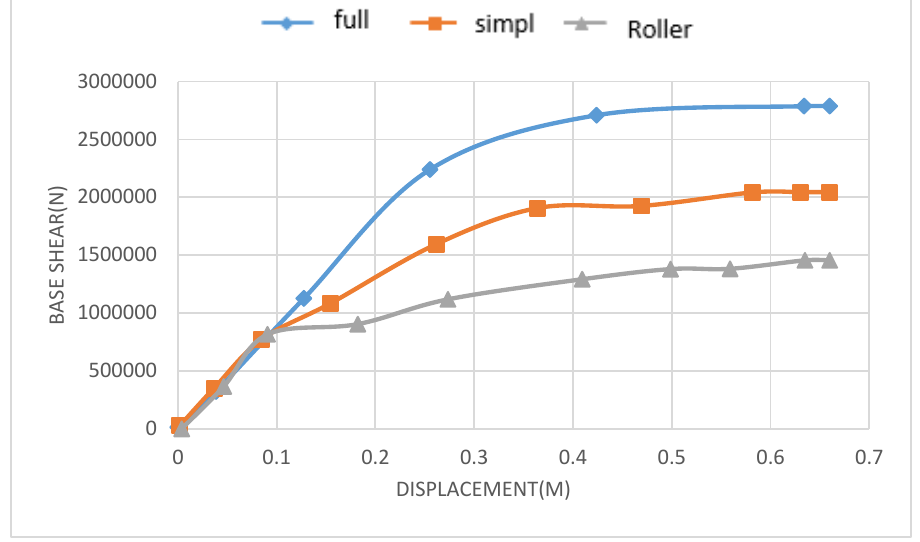
Fig. 18. 6 spans bridge with base height 6 meters in transverse